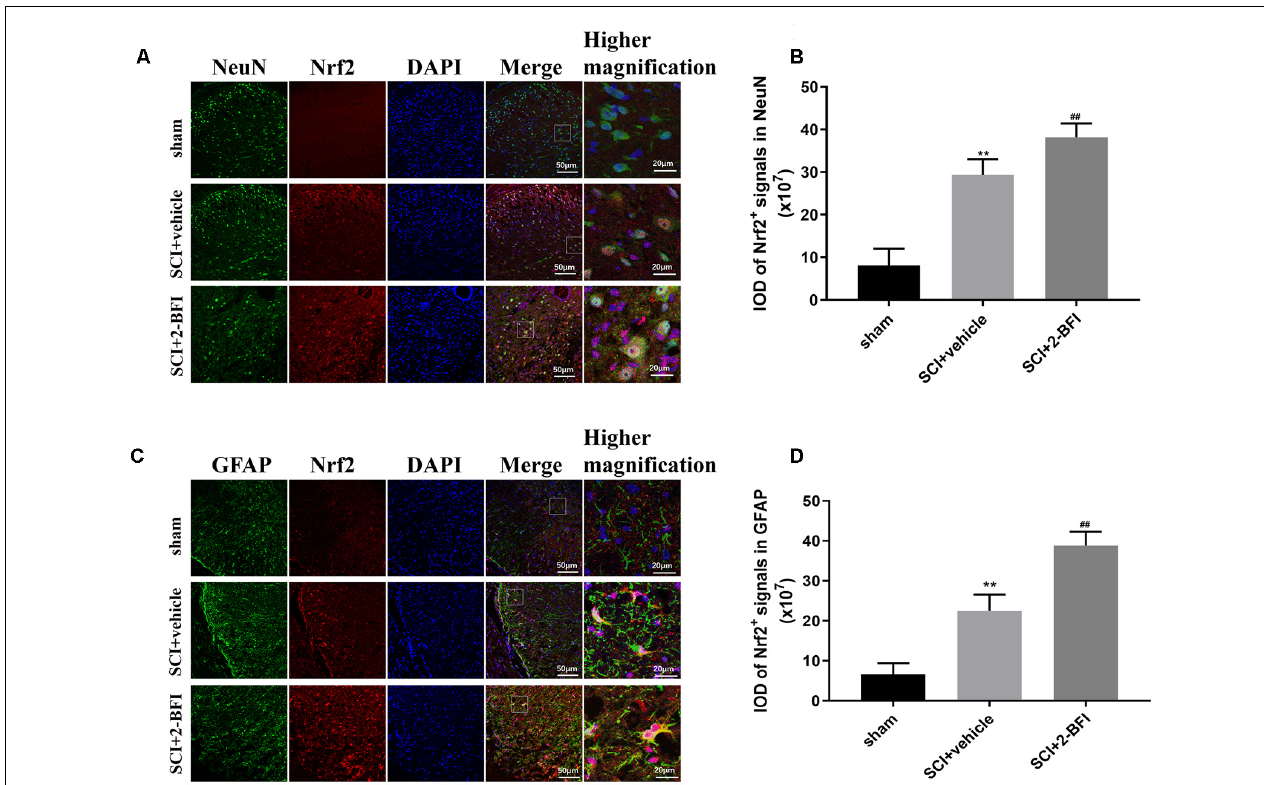
FIGURE 4 | Double-immunofluorescence staining images of Nrf2 (red) with NeuN (green)-marked neurons (A) and Nrf2 (red) with GFAF (green)-marked astrocytes (C) to show the expression profiles in the sham group, vehicle group and 2-BFI group. Nuclei were counterstained with DAPI (blue) in the same view for each section. Immunofluorescence analysis was used to detect the IOD of Nrf2 signals in neurons (B) and astrocytes (D) at day 3 after the operation. Scale bars are 10 µ m. Immunofluorescence intensities were determined using ImageJ software. n = 6 animals per group. Columns represent the mean ± SD. ∗∗ P < 0.01 vs. the sham group; ## P < 0.01 vs. the SCI+vehicle